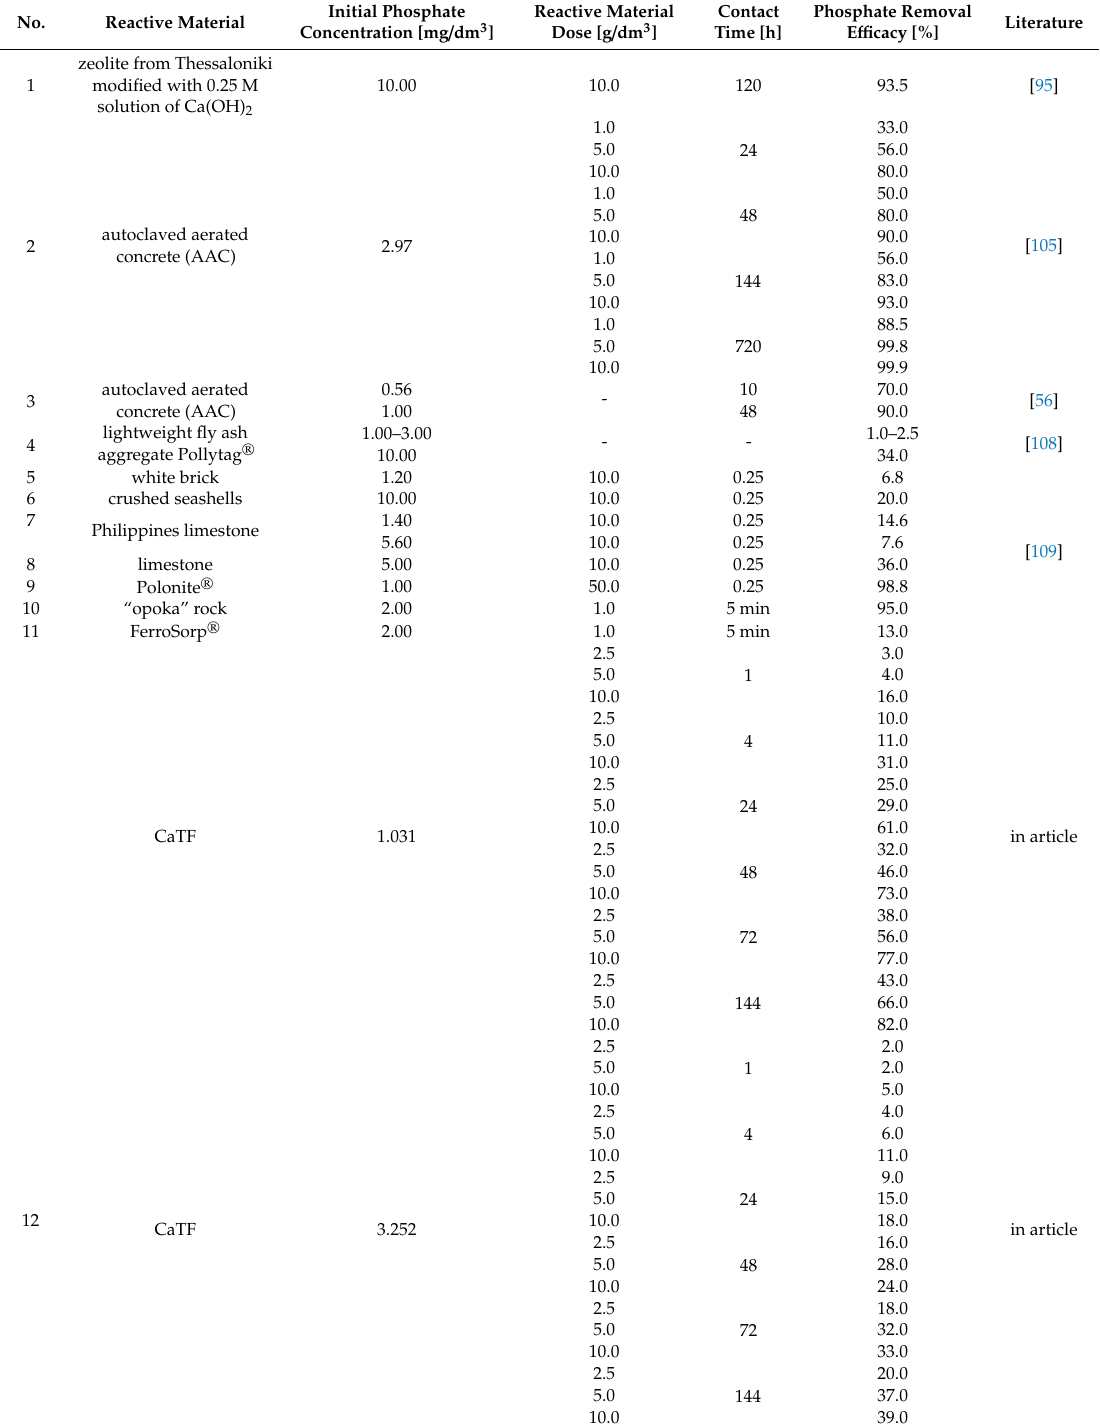
Table 7. The e ffi cacies of phosphate removal from aqueous solutions using reactive